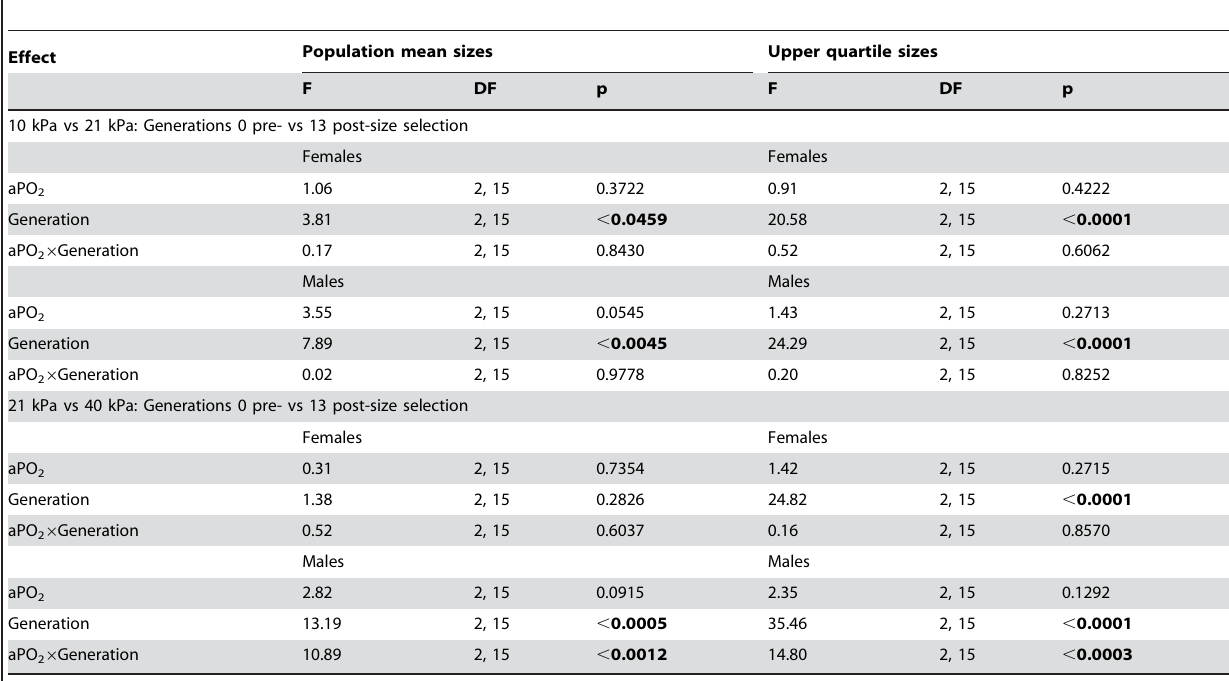
Table 2. Statistical analyses of variation of initial fly sizes vs. the size of flies post-selection–all reared in normoxic